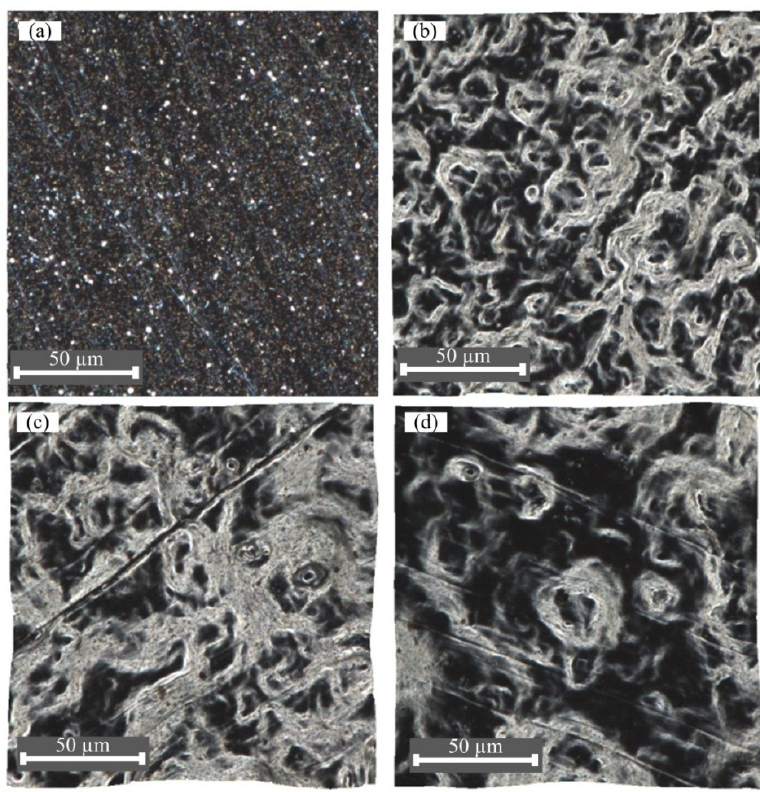
Figure 7. ( a ) The polished specimen surface; variations of surface microstructures at the standoff distances of ( b ) 0.1 mm, ( c ) 0.6 mm and ( d ) 1.0 mm.